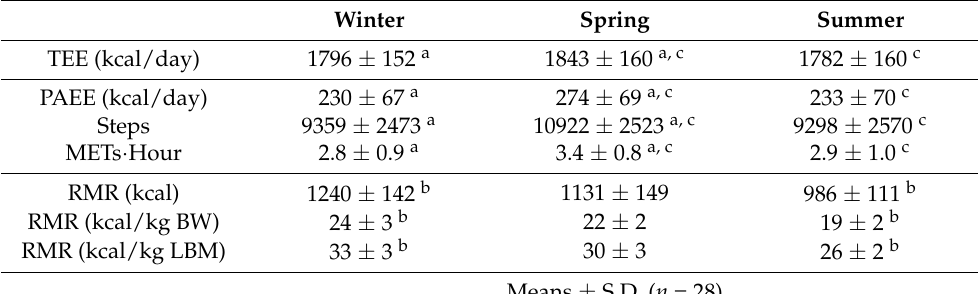
Table 4. Seasonal changes in physical activity and resting metabolic rate